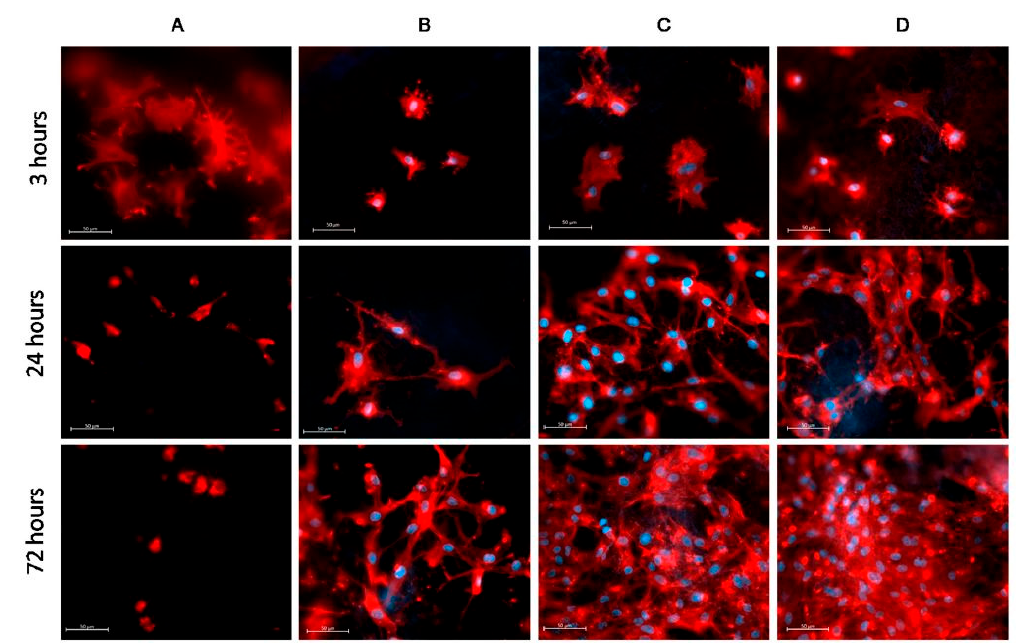
Figure 24. Adhesion of MSCs on the surface of untreated PCL ( A ), COOH-coated PCL ( B ), COOH-coated PCL with physically adsorbed PRP ( C ) and COOH-coated PCL with covalently immobilized PRP ( D ). All images were taken with a magnification of 40× and the scale bar corresponds to 50 µm—reproduced from [294] and [296]. Copyright Wiley, 2007.